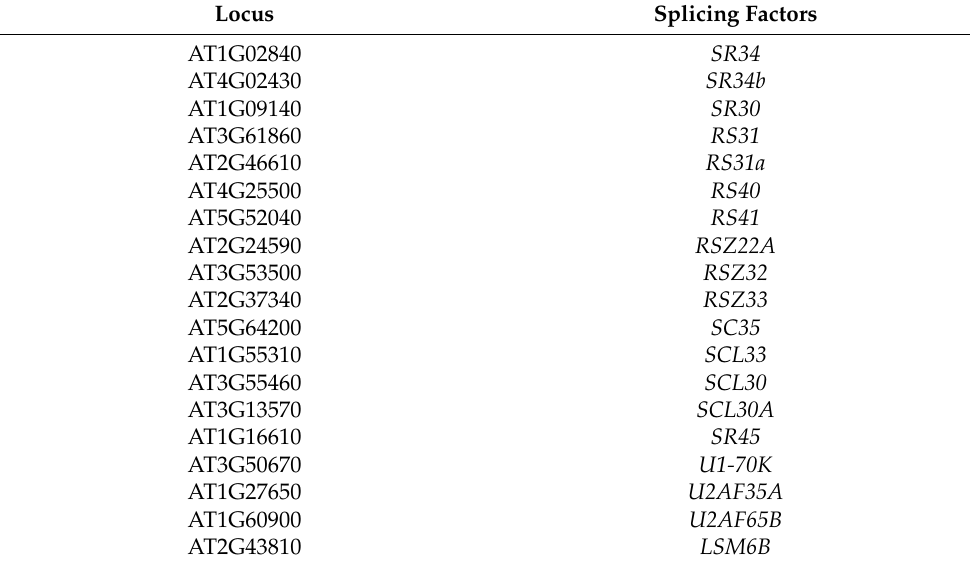
Table 3. Summary of ABA-induced alternative splicing events of Arabidopsis splicing factors [67,71]. Locus Splicing Factors AT1G02840 SR34 AT4G02430 SR34b AT1G09140 SR30 AT3G61860 RS31 AT2G46610 RS31a AT4G25500 RS40 AT5G52040 RS41 AT2G24590 RSZ22A AT3G53500 RSZ32 AT2G37340 RSZ33 AT5G64200 SC35 SCL33